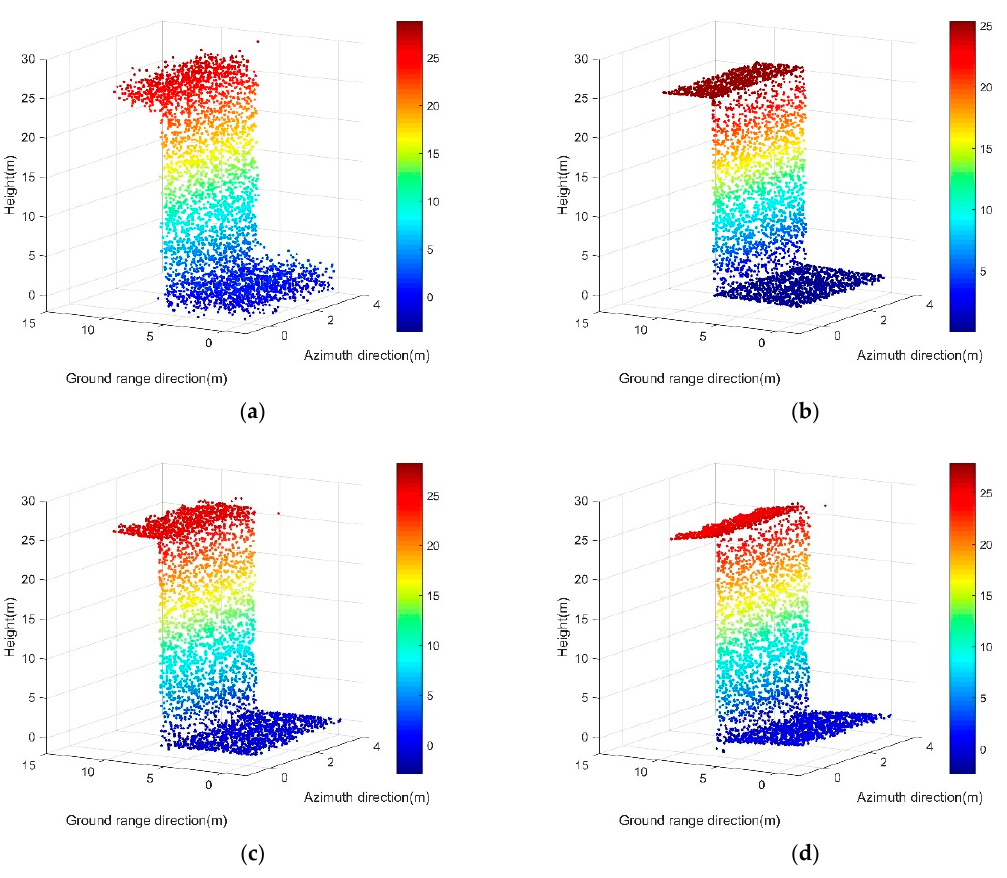
Figure 13. Results on the front side of the simulated building. ( a ) Original simulated point clouds from one side looking. ( b ) Results of our proposed method; ( c ) Results of the RANSAC algorithm; ( d ) Results of the TomoSeed algorithm.